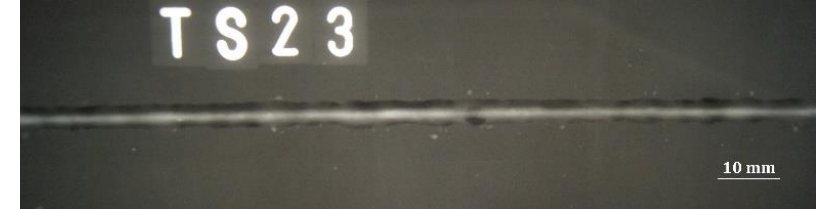
Figure 5. Photo of a test of a hybrid welded joint in S1300QL steel.